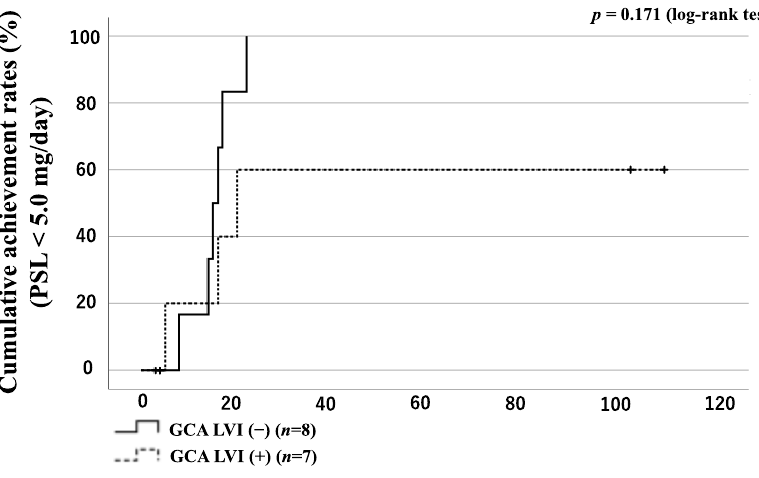
Figure 7. Rates of patients with GCA with and without LVI achieving the tapered PSL dose (PSL < Figure 6. Rates of patients with GCA with and without immunosuppressant achieving the tapered 5.0 mg/day). Rates of patients with GCA achieving a tapered PSL dose (PSL < 5.0 mg/day). The PSL dose (PSL < 5.0 mg/day). Rates of patients with GCA achieving a tapered PSL dose proportions of patients who achieved a tapered PSL dose were compared with patients with GCA treated with or without LVI using Kaplan–Meier curves. The starting point (0 months) was the date of the initiation of remission induction therapy. There was no significant difference between the LVI(+) and LVI( − )